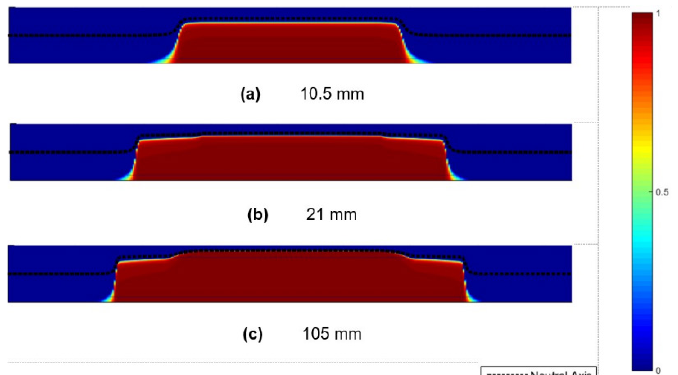
Figure 9. Damage configuration for different midspan displacements in Mazars'